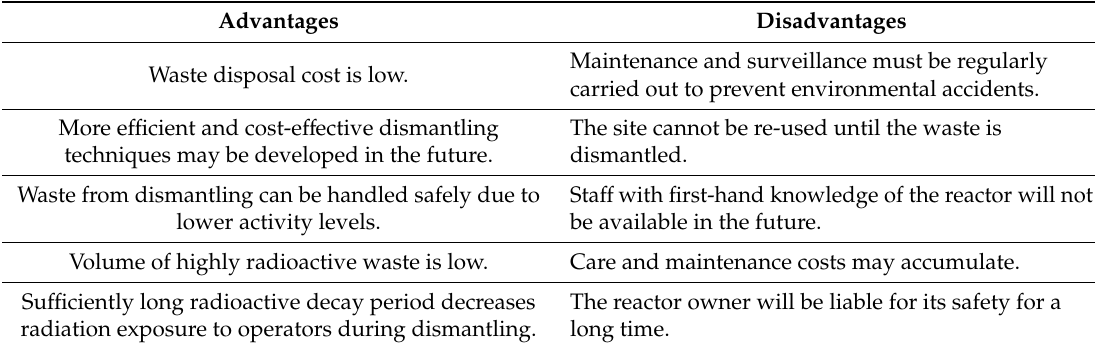
Figure 6. Dose rates resulting from reactor graphite after reactor shutdown. Table 1. Main features of the long-term storage of radioactive waste containing i